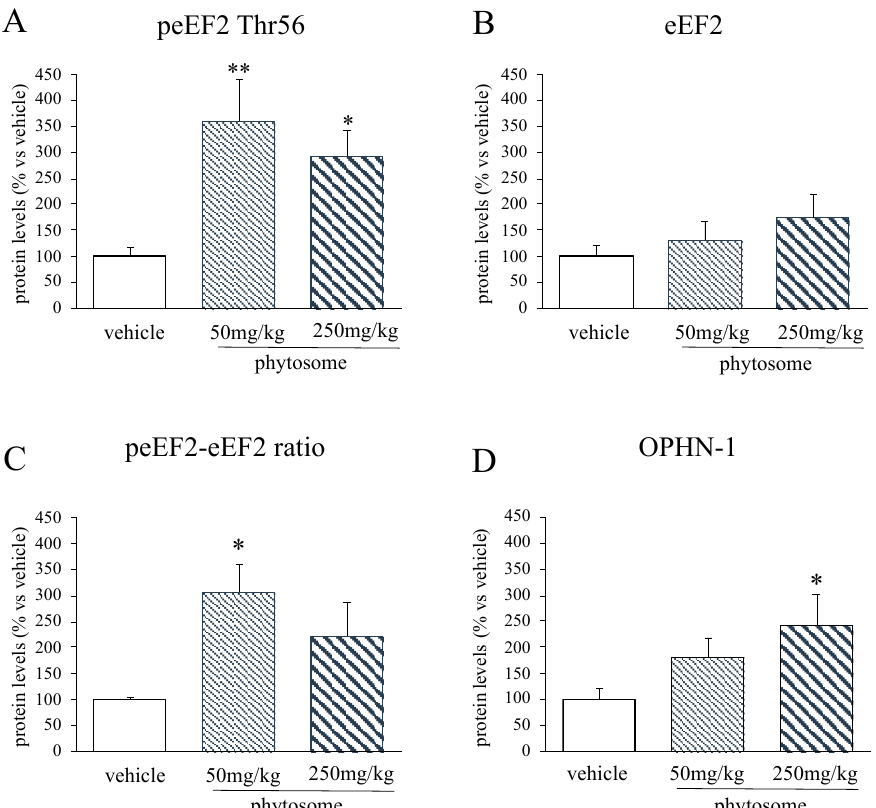
Figure 5. Analyses of eEF2 ( A – C ) and OPHN-1 ( D ) protein levels in the PFC of rats treated with phytosome 50 mg/kg or 250 mg/kg. Data are expressed as percent change of vehicle treated rats and are represented in the histograms graphs as mean ± SEM of 4–6 independent determinations. * p < 0.05, ** p < 0.01 vs. vehicle; one-way ANOVA with Fisher’s PLSD.